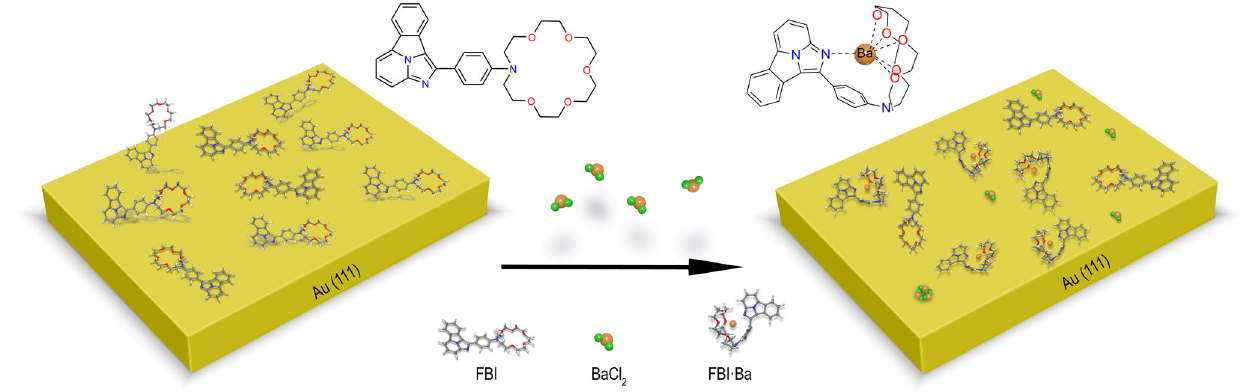
Fig. 1 | Model of the FBI molecules before and after chelation. Schematic representation of the experiment we have carried out. FBI molecules were sublimated on a Au(111) surface, chelated in situ and characterized inside the UHV chamber.